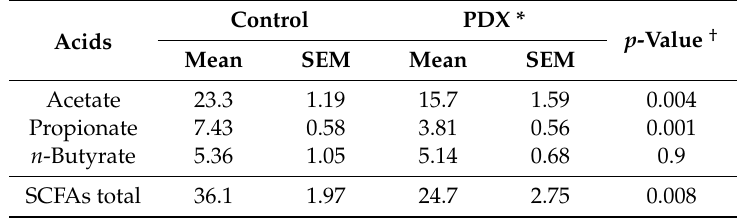
Table 2. Short-chain fatty acids (SCFAs) concentration in the portal vein, 4 weeks after feeding ( µ mol / L). Control PDX * Acids p -value † Mean SEM Mean SEM Acetate 227.2 16.48 305.8 13.84 0.005 Propionate 43.62 3.270 42.80 6.722 0.9 n -Butyrate 27.93 3.318 46.90 6.221 SCFAs total 298.7 19.20 395.5 16.92